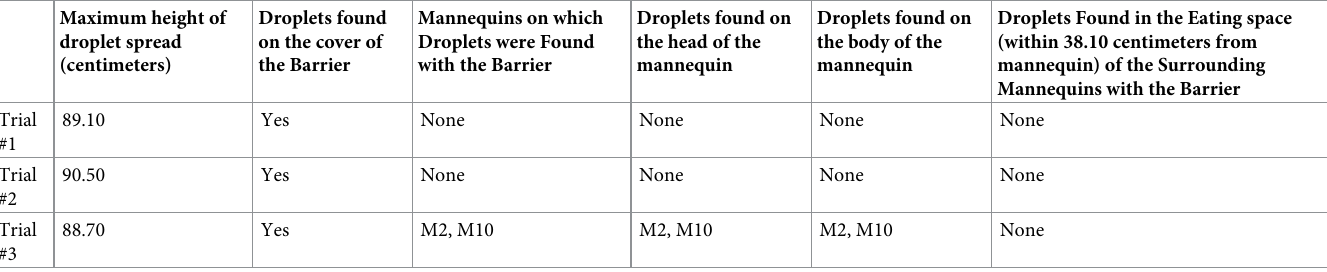
Table 4. (Experiment 4): Droplet spread with barrier use.